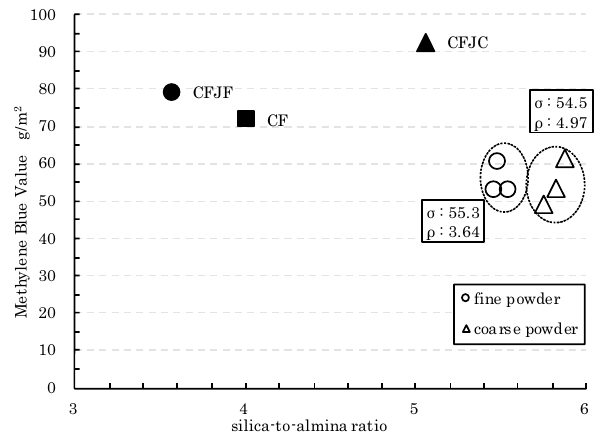
Fig. 15 Relationship between BET surface area and MB adsorption of VGP and Clay powder. Here, σ is average of MB value, ρis stand- ard deviations